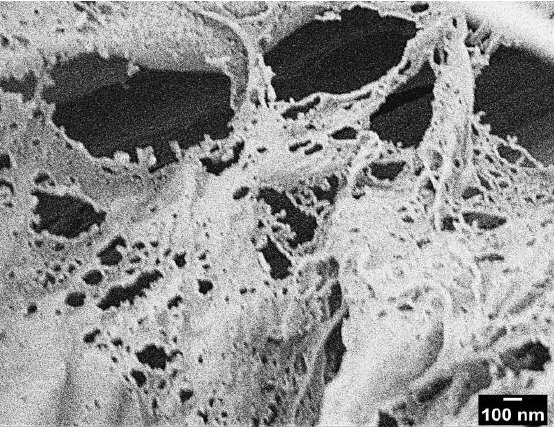
Figure 1. FE-SEM image of FD-CNFs provided by MOORIM P&P.